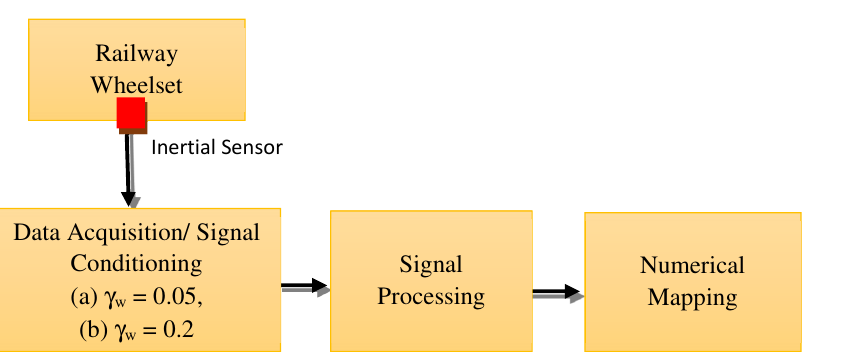
Fig. 4: Block diagram model for identifying changes in Conicity